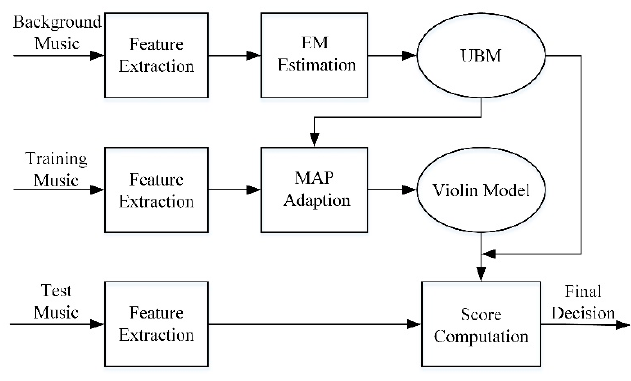
Figure 6. GMM–UBM based recognition system.